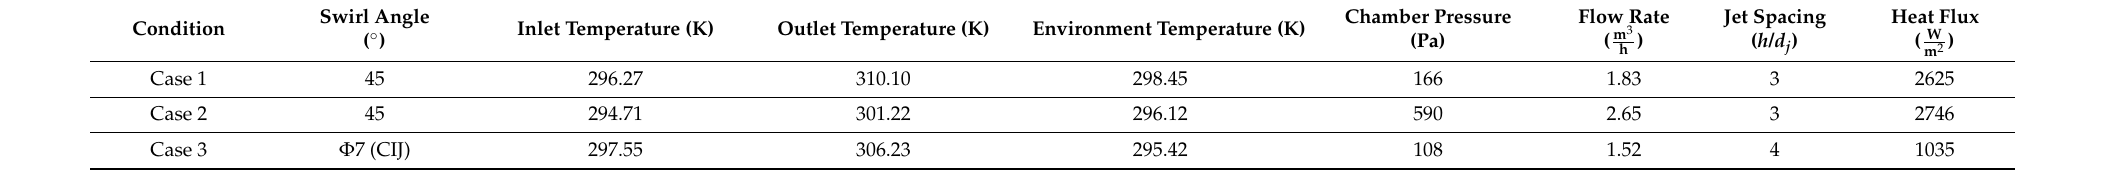
Table 2. Experimental conditions and partial data measurement